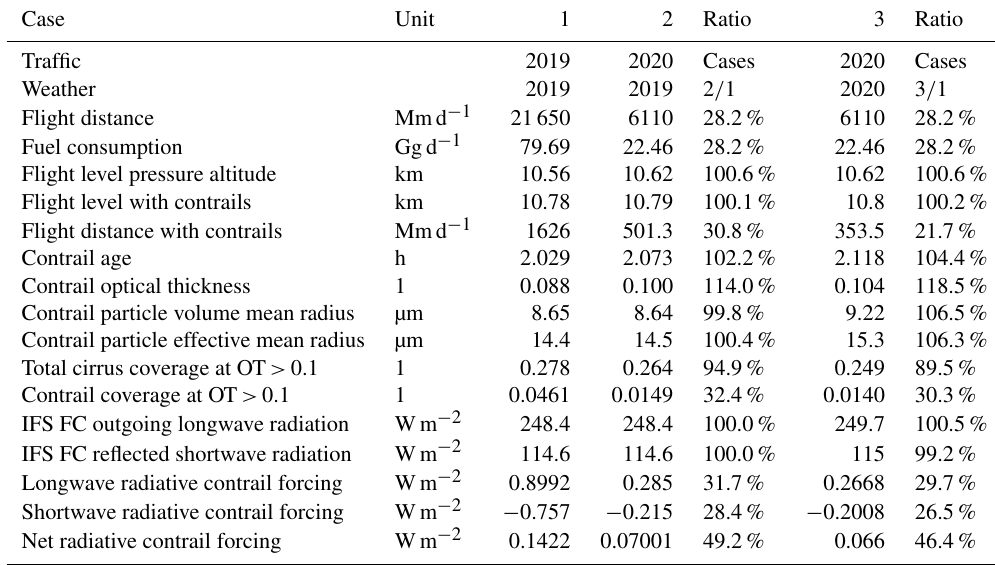
Table 3. Six-month mean air traffic and contrail properties for traffic and weather in various years. Case